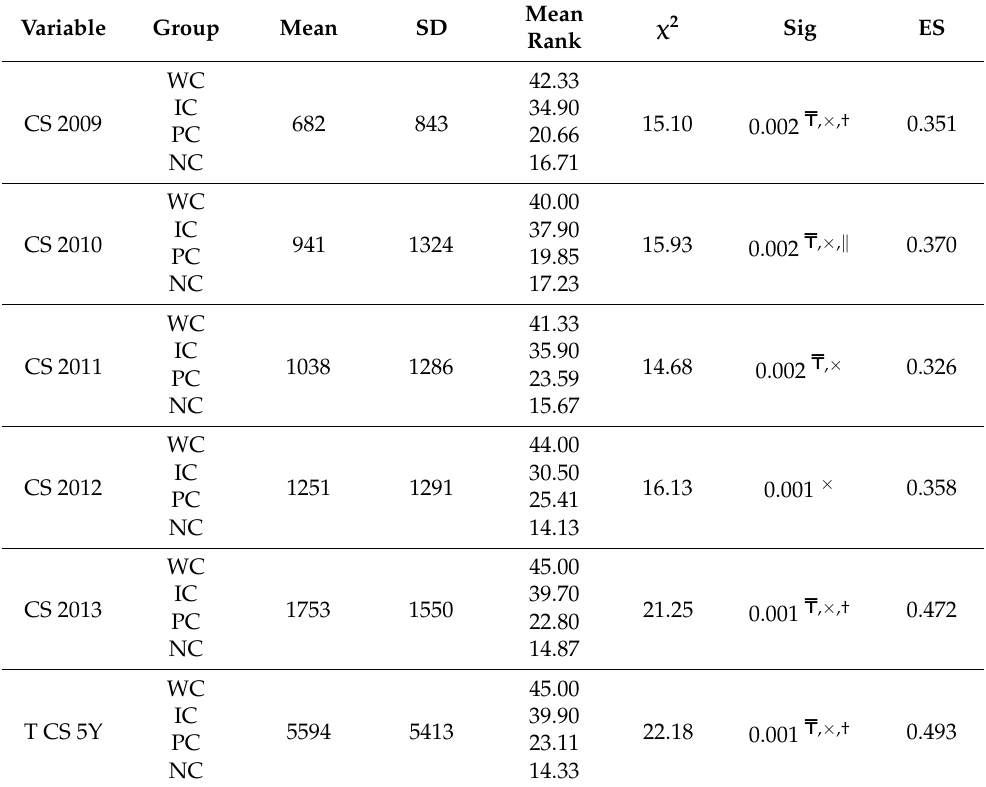
Table 4. Difference between Categorisation groups for Competition Success (CS) for selected years with Kruskal–Wallis test and effect size.